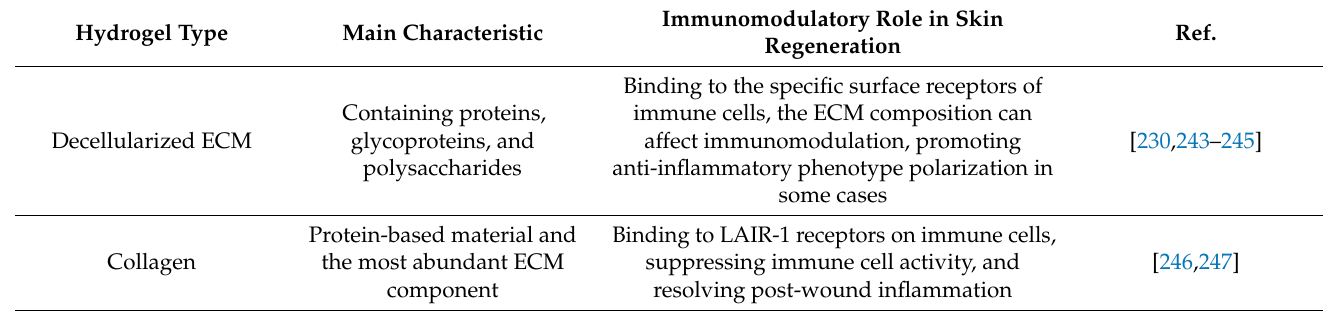
Figure 7. Infiltration of distinct subsets of macrophages into vascDESS in vivo. ( a , b ) Infiltration of iNOS M1 macrophages into vascDESS in vivo. Double-label immunofluorescence for iNOS macrophages (green) and human CD90 (red) in vascDESS at 1 and 3 weeks of post-transplantation. ( c , d ) Expression of CD206 in transplanted vascDESS in vivo. M2 macrophages were detected with an antibody against CD206 (green) within the human CD90-stained neodermis (red). CD206 macrophage (M2) density was increased in vascDESS after 3 weeks as compared to 1 week in vivo. ( e , f ) The quantification of iNOS and CD206 density in transplanted skin analogs at 1 and 3 weeks in vivo (** p < 0.01,*** p < 0.001) [158]. Table 2. Summary of research studies conducted on natural hydrogel-based materials used for immunomodulation of skin